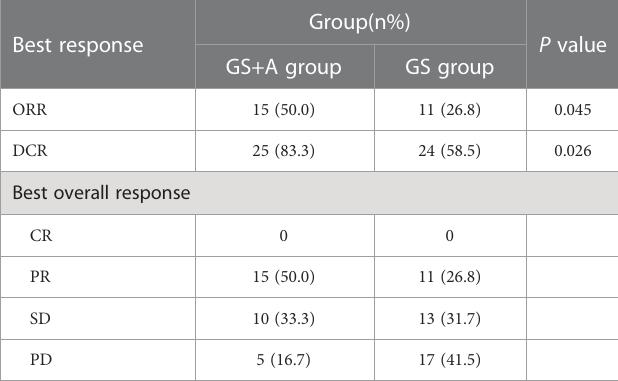
TABLE 2 Treatment response of the